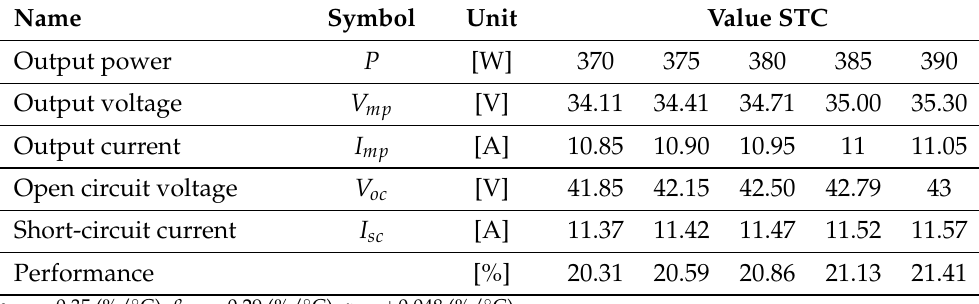
Table 1. Typical current–voltage characteristics of a properly functioning PV